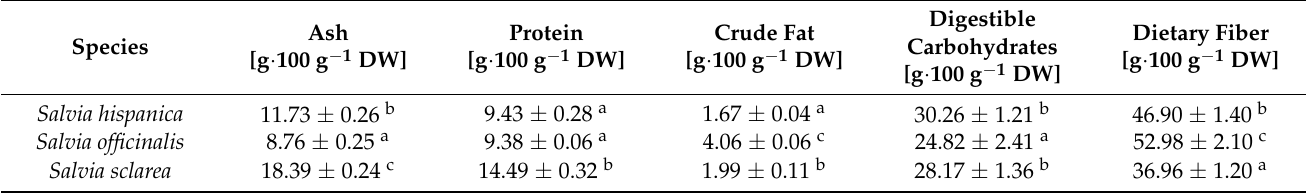
Table 1. Basic chemical composition of individual species of sage.